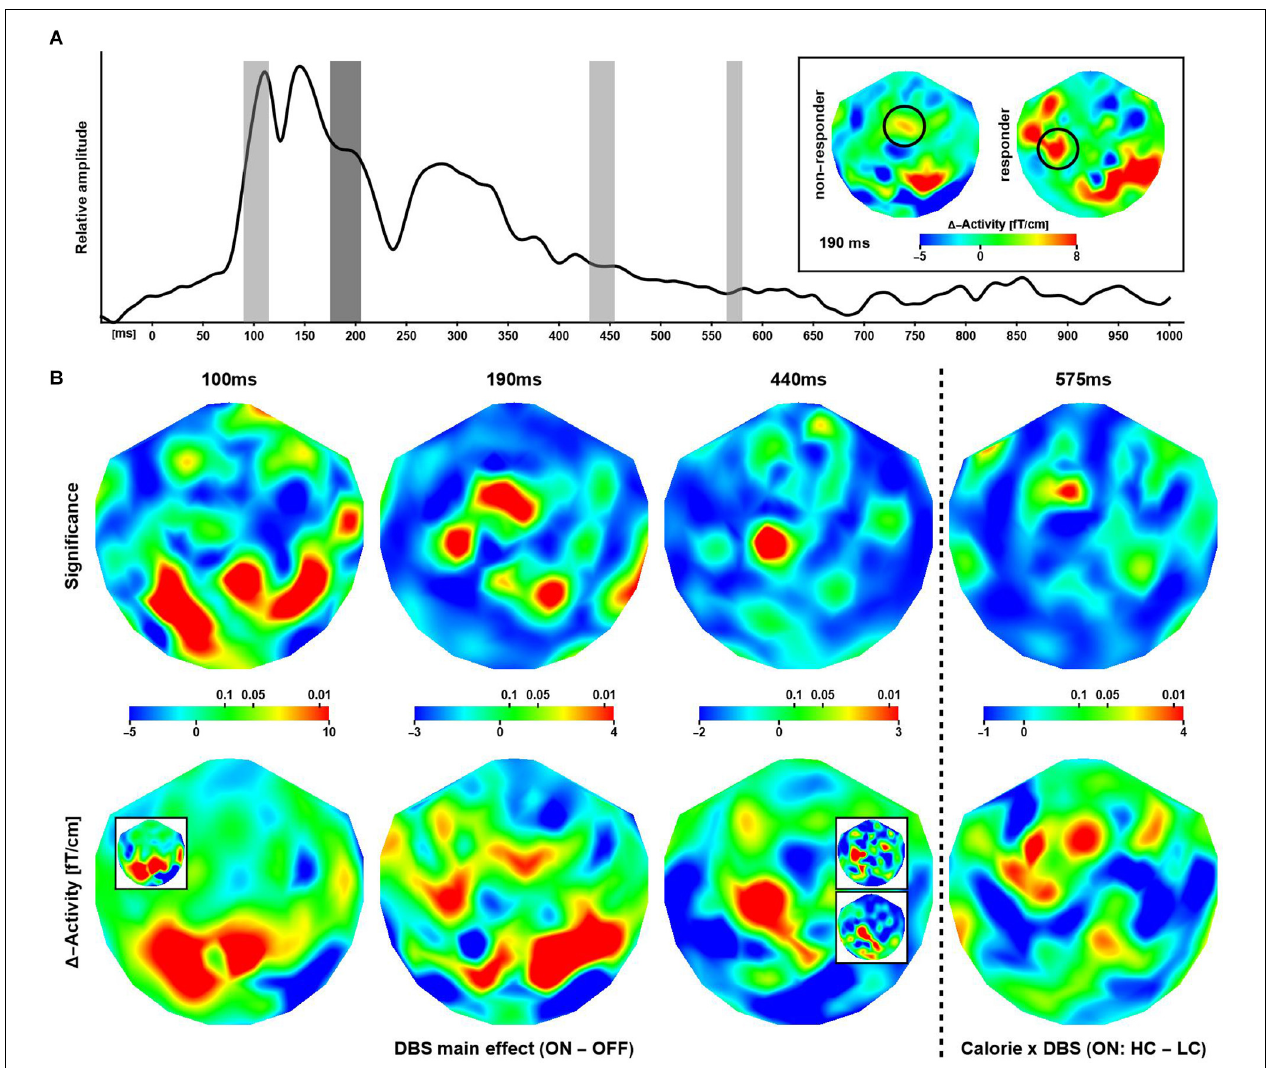
FIGURE 3 | Effects of deep brain stimulation and calorific value on evoked responses. (A) Shown is the global evoked power summed over all subjects, trials, and channels. The gray bars indicate time intervals where a significant modulation of the neuronal response was observed. The inset shows differential (ON–OFF) activity maps corresponding to the effect at 190 ms (highlighted in dark gray in the graph) for non-responders and responders. The circles indicate a putative lateralization of activity in responders during stimulation. (B) The maps show the distribution of significance (upper row) corresponding to differential effects of stimulations at three latencies and one interaction effect between stimulation and image type. The (differential) activity maps shown in the lower row are based on evoked power (squared ERF) calculations, however, for visual presentation, the (grand-mean) data have been transformed back to the physical unit (fT/cm) of the MEG gradiometers. Note that some regions of significance exhibit only small differential effects and larger differences in evoked activity are not significant. The insets (bottom row) illustrate the consistency of results when considering subsets of sessions. 100 ms: Session-3 (ON) minus Session-4 (OFF). 440 ms upper: ON minus OFF (sessions 1, 2, 5); lower: ON minus OFF (sessions 3, 4). See text for